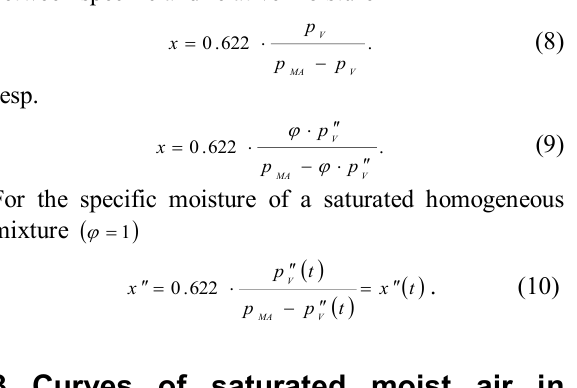
kg/kg x in p – t diagram (detail) [4]. DAV